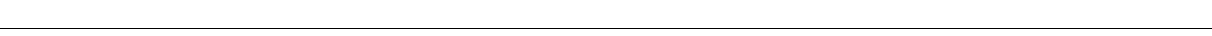
Fig. 2 Electrophysiological analysis of Ks -Amt5 in proteoliposomes. a Transient currents recorded at lipid:protein ratios (LPR) of 10:1 and 30:1 vs. protein- free liposomes reveal speci fi c charge displacement events in the presence of Ks -Amt5. b Bar graph of the peak current (violet, nA) and half-maximum decay time (green, ms) values from a . The unchanged decay time points towards charge displacement rather than ion translocation. c Transient currents recorded at pH 7.5 for different cations (300 mM) at a LPR of 10:1. Ks -Amt5 is highly speci fi c for NH 4 + , but does not act on methylammonium (MA) or dimethylammonium (DMA), which are alternative substrates of assimilatory Amt proteins. d Bar graph of the peak currents measured in c and the respective backgrounds (yellow). Only NH 4 + , but not MA or DMA, triggered an electrogenic response. e pH-dependent transients induced by 300 mM NH 4 + concentration jumps. f Variation of normalized peak currents with pH (as in e ). The fi t (solid line) used a titration function 70 yielding a pK app of 5.5. g Saturation behavior of NH 4 + transients at pH 7.5 with increasing concentration of the ion. h Normalized peak currents with respect to NH 4 + concentration at pH 7.5 and 7.0. The af fi nity for the cations is increased at the higher pH value ( K 0.5 app , pH 7.5 = 22.9 ± 0.87 mM fi tted with a Hill coef fi cient of 0.75). All experiments were done at least in triplicate on two different protein reconstitutions and two separate protein batches. Error bars are thus calculated from